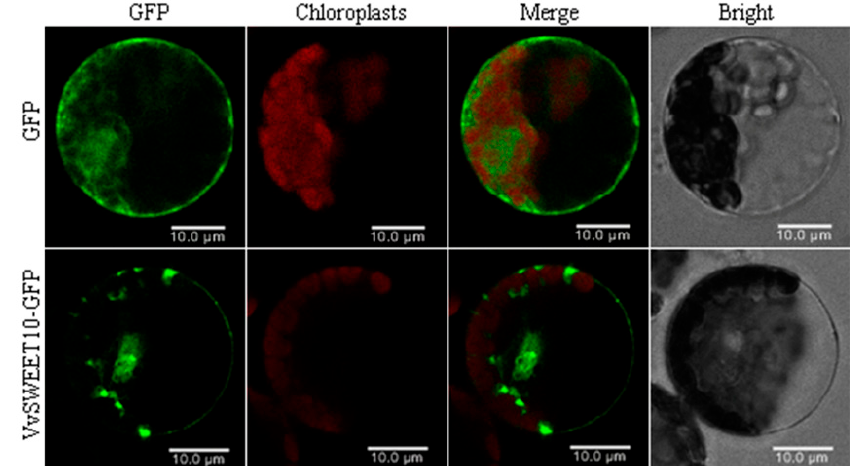
Figure 3. Subcellular localization of VvSWEET10 proteins. The transient expression of VvSWEET10-GFP and free GFP (as a control) under the control of the 35S promoter in tobacco protoplasts. The fluorescent signal was imaged by confocal microscopy, GFP green fluorescence, and chlorophyll autofluorescence; bright-field images and merged images are shown. Scale bars = 10 μ m.